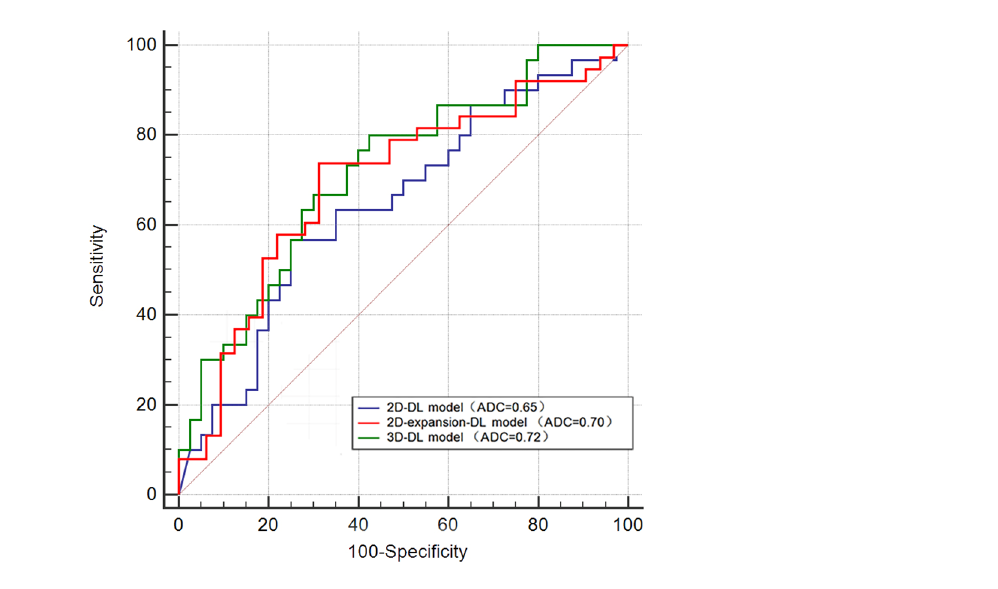
FIGURE 2 The ROC curves of the three models in the testing set.